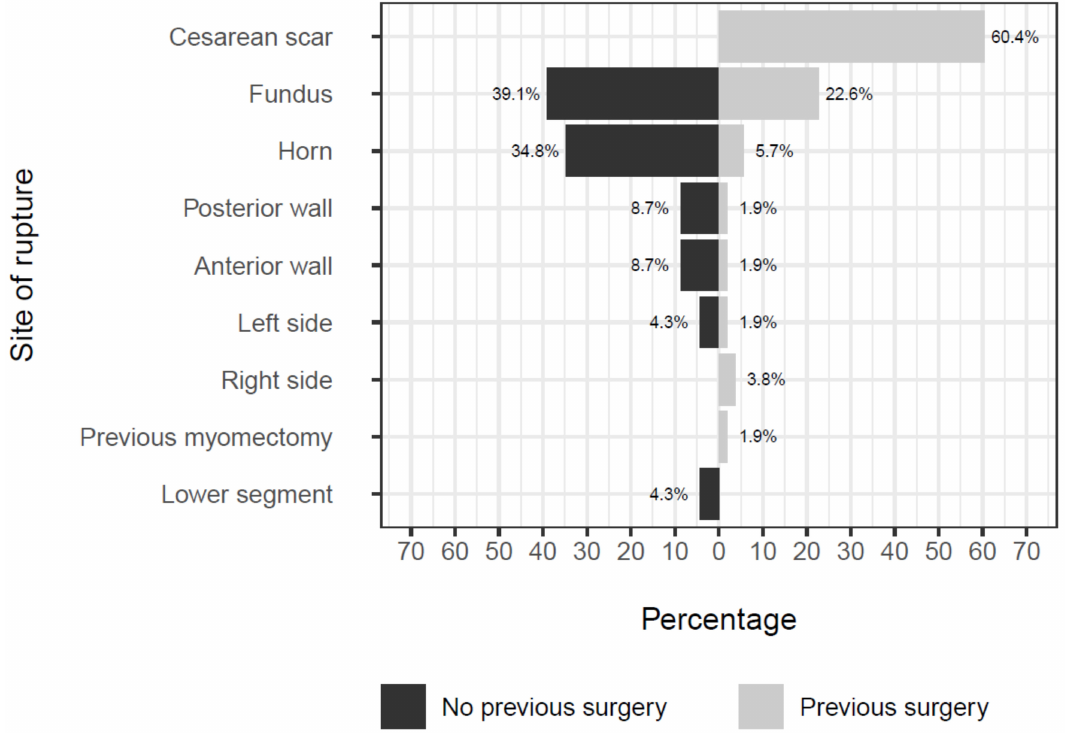
Figure 3. Plot showing rupture site among patients with and without previous